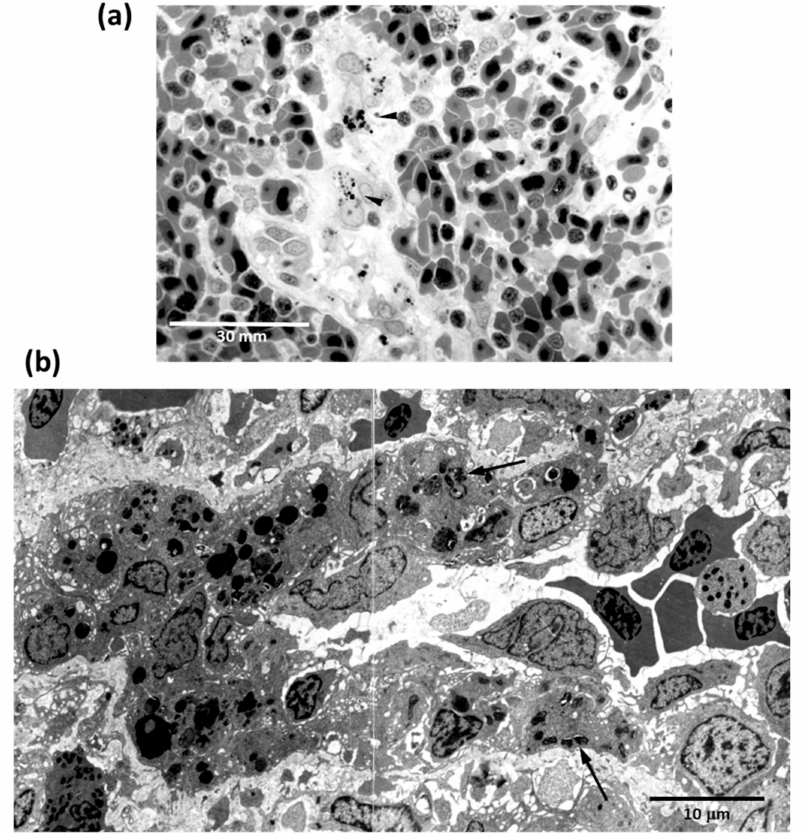
Figure 3. Light microscopy of the carbon uptake (arrowheads) by macrophages surrounding the splenic ellipsoids of Carassius auratus ( a ). By electron microscopy, ellipsoid macrophages (arrows) appear full off engulfed bacteria after intraperitoneal injection of Yersinia ruckeri ( b